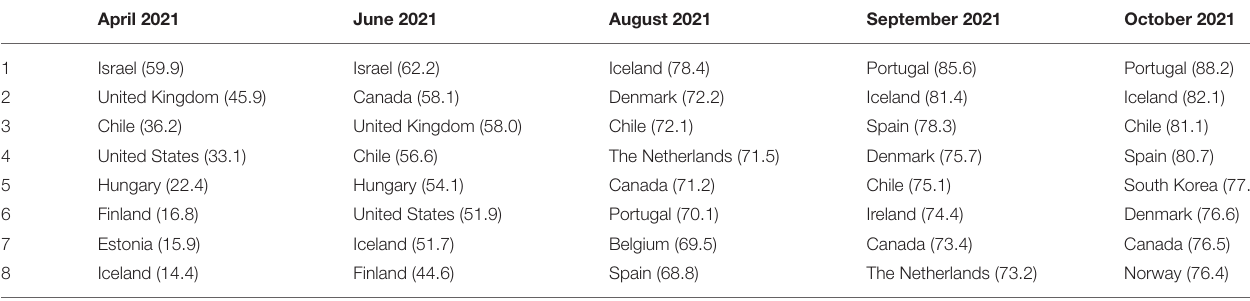
TABLE 1 | The percentage (%) prevalence of COVID-19 vaccination (top eight OECD member nations).